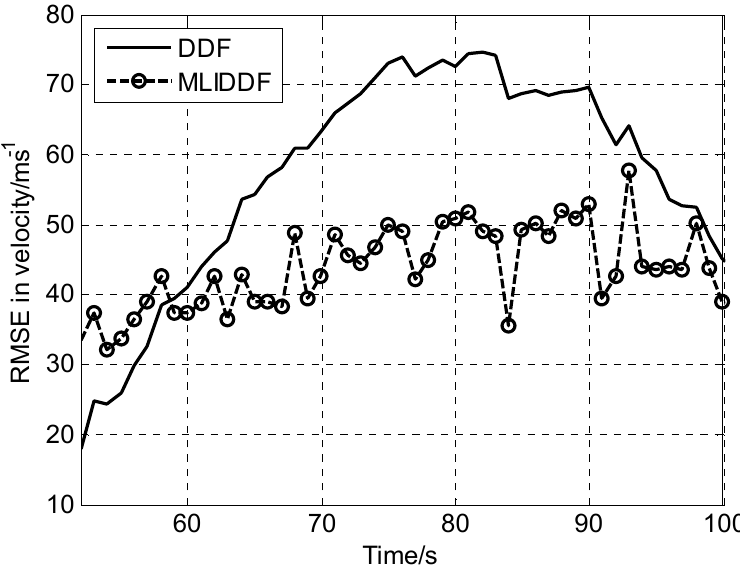
Figure 3. RMSE in turn rate for DDF and